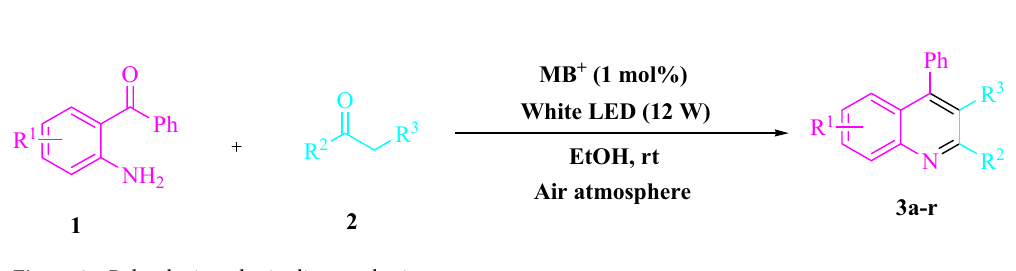
Figure 3. Polysubstitutedquinoline